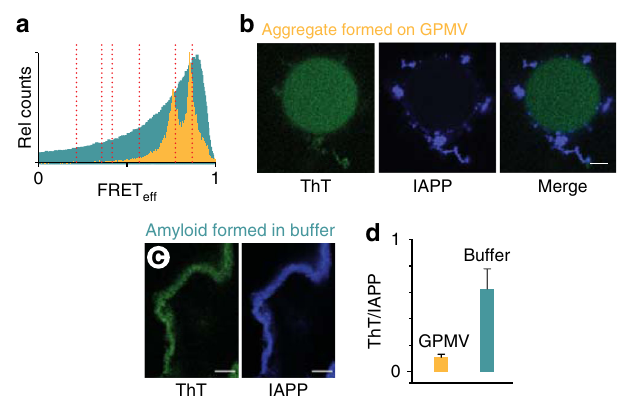
Fig. 10 IAPP oligomers on GPMVs are not amyloid. a Intermolecular FRET eff statistics from 50 ROIs of aggregates prepared using IAPP A488 , IAPP A647 and unlabelled IAPP (1:1:500). GPMV induced aggregates (orange) were prepared under conditions of 10:1:0 IAPP:lipid:ADM-116 with images taken 60 ′ after exposure of 50 μ M IAPP to 5 μ M GPMV. These are overlaid with FRET eff statistics of a control in which IAPP is in an amyloid conformation at 1:1:500 (Fig. 6a). Confocal imaging and FRET eff analysis was performed using procedures identical to that used for the GPMVs. Vertical dotted red lines correspond to specie positions de fi ned in Fig. 8e. b , c Confocal imaging of IAPP aggregates prepared from IAPP doped with IAPP A647 (500:1) and further stained with the amyloid indicator dye, ThT. Two channel image pairs are shown for ThT (green) and IAPP A647 (blue), respectively. Aggregates were prepared either in the presence of GPMVs ( b ) or in buffer ( c ). Scale bar for all images is 5 μ m. d Image statistics for data as in b , c . Presented ThT intensities normalised to IAPP A647 intensities using ROIs away from the GPMV surface. Error bars are